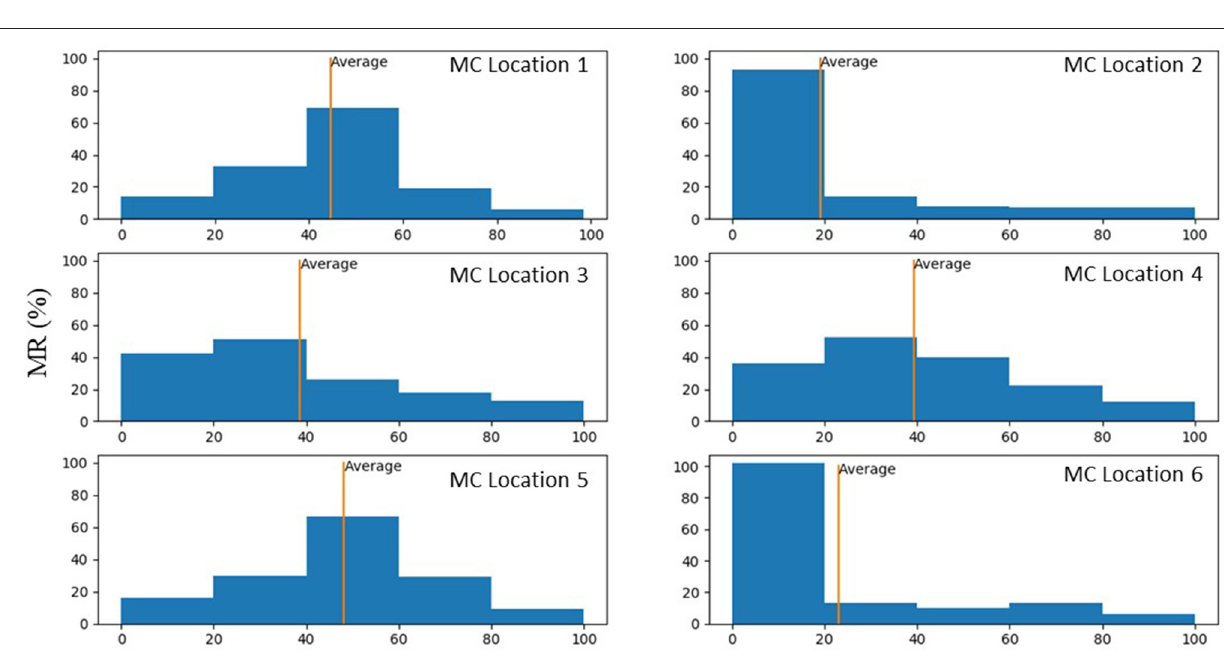
FIGURE 9 | Histograms that show percentage of MR reduction in the MV for each MC location. These histograms were plotted only for scenarios where MR reduced after MC